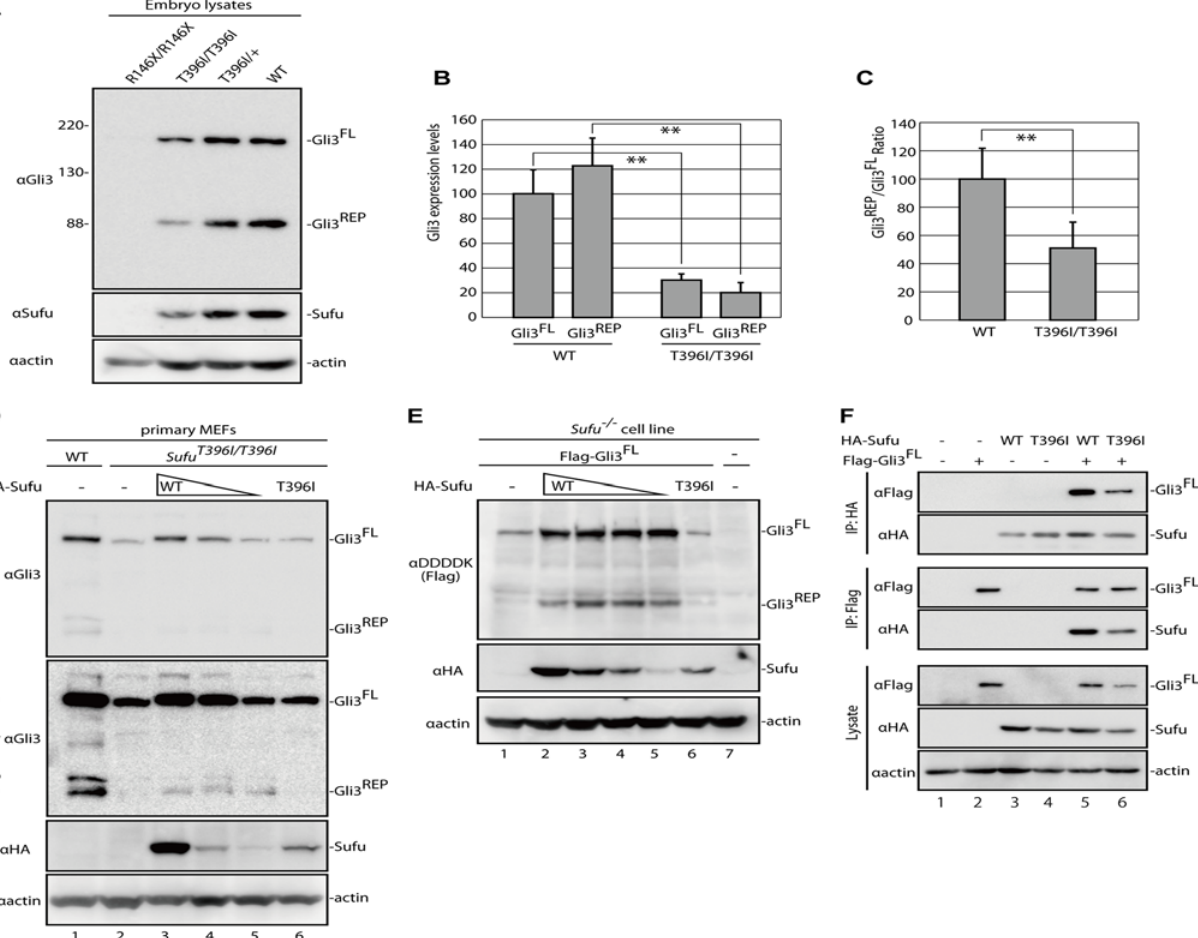
Fig 2. Sufu T396I does not stabilize Gli3 FL protein and reduces the processing of Gli3 FL . ( A ) Western blotting of lysates prepared from Sufu R146X/R146X at E9.5 and Sufu T396I/T396I , Sufu T396I/+ , and wild-type embryos at E10.5 with anti-Gli3, anti-Sufu, and anti-actin antibodies. Each image presented in the Fig. is a representative of independent triplicated experiments. The full gel images are shown in S6A Fig. ( B, C ) Relative expression of Gli3 FL (B) and Gli3 REP (B and C). Western blotting was performed two times using lysates prepared from five wild-type and five Sufu T396I/T396I embryos at E10.5 (S2A Fig.). Expression levels were quantified from the band intensity shown in S2A Fig. as relative values of the Gli3 FL /actin and Gli3 REP /actin expression ratios (B) and the direct ratio of Gli3 REP /Gli3 FL (C). ( ** ) p < 0.01, two-tailed Student ’ s t-test. Error bars indicate the standard deviations. ( D ) Western blotting of cell lysates from wild- type and Sufu T396I/T396I MEFs with indicated antibodies. The Sufu T396I/T396I MEFs were electroporated with 10.0, 1.0, or 0.1 μ g of the HA – Sufu construct (lane 3, 4, and 5, respectively), or 10 μ g of the HA – Sufu T396I construct (lane 6). The mobilities on SDS-PAGE of the wild-type Sufu (lane 3 – 5) and Sufu T396I (lane 6) are identical. The complete gel images are shown in S6B Fig. This image is representative of two independent experiments. (E) Western blotting of cell lysates from Sufu − / − cells with indicated antibodies. The Sufu − / − cells were electroporated with a mixture of the Flag – Gli3 construct (6 μ g) and the HA – Sufu construct (4.00, 1.33, 0.44, or 0.15 μ g) for the wild-type Sufu cotransfection (lane 2 to 5, respectively), or a mixture of the Flag – Gli3 construct (6 μ g) and the HA – Sufu T396I construct (4 μ g) for mutant Sufu cotransfection (lane 6). The complete gel images are shown in S6C Fig. This image is representative of two independent experiments. (F) Western blotting of immunoprecipitates or lysates from 293T cells transfected with expression constructs as indicated at the top. The complete gel images are shown in S6D Fig. This image is representative of two independent